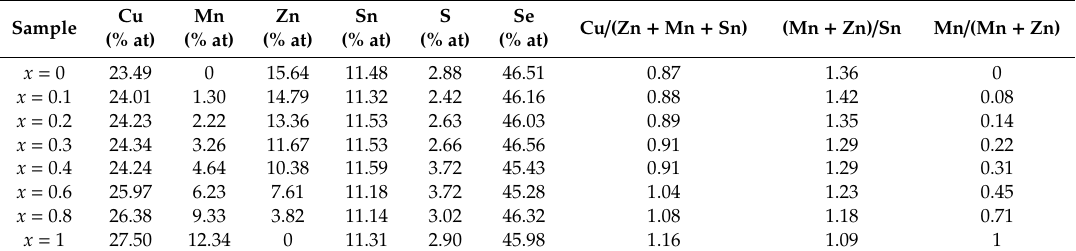
Table 1. Summary of the EDS results of Cu 2 Mn x Zn 1 − x Sn(S,Se) 4 (0 ≤ x ≤ 1) thin films with various Mn